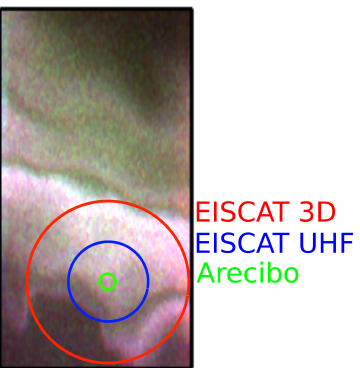
Figure 1. An image of auroral optical emission in the magnetic- field-aligned direction, showing the horizontal distribution of the auroral precipitating electron flux. Overlain on the image are the beam widths of the EISCAT UHF, Arecibo, and EISCAT 3D radars, with approximately 0.5 ◦ , 0.16 ◦ , and 1.0 ◦ beam widths. The image is from the Auroral Structure and Kinetics (ASK) instrument (Ashrafi, 2007), courtesy of Daniel K.